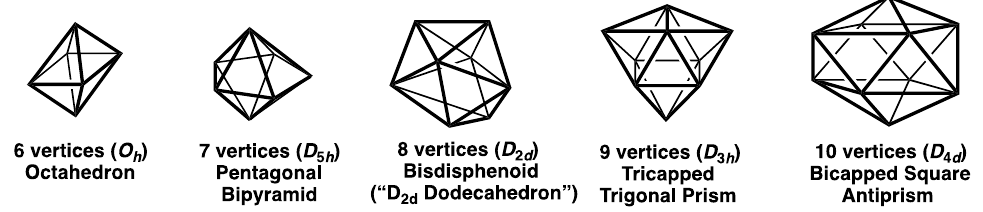
Figure 1. The most spherical closo polyhedra having 6 to 10 vertices.